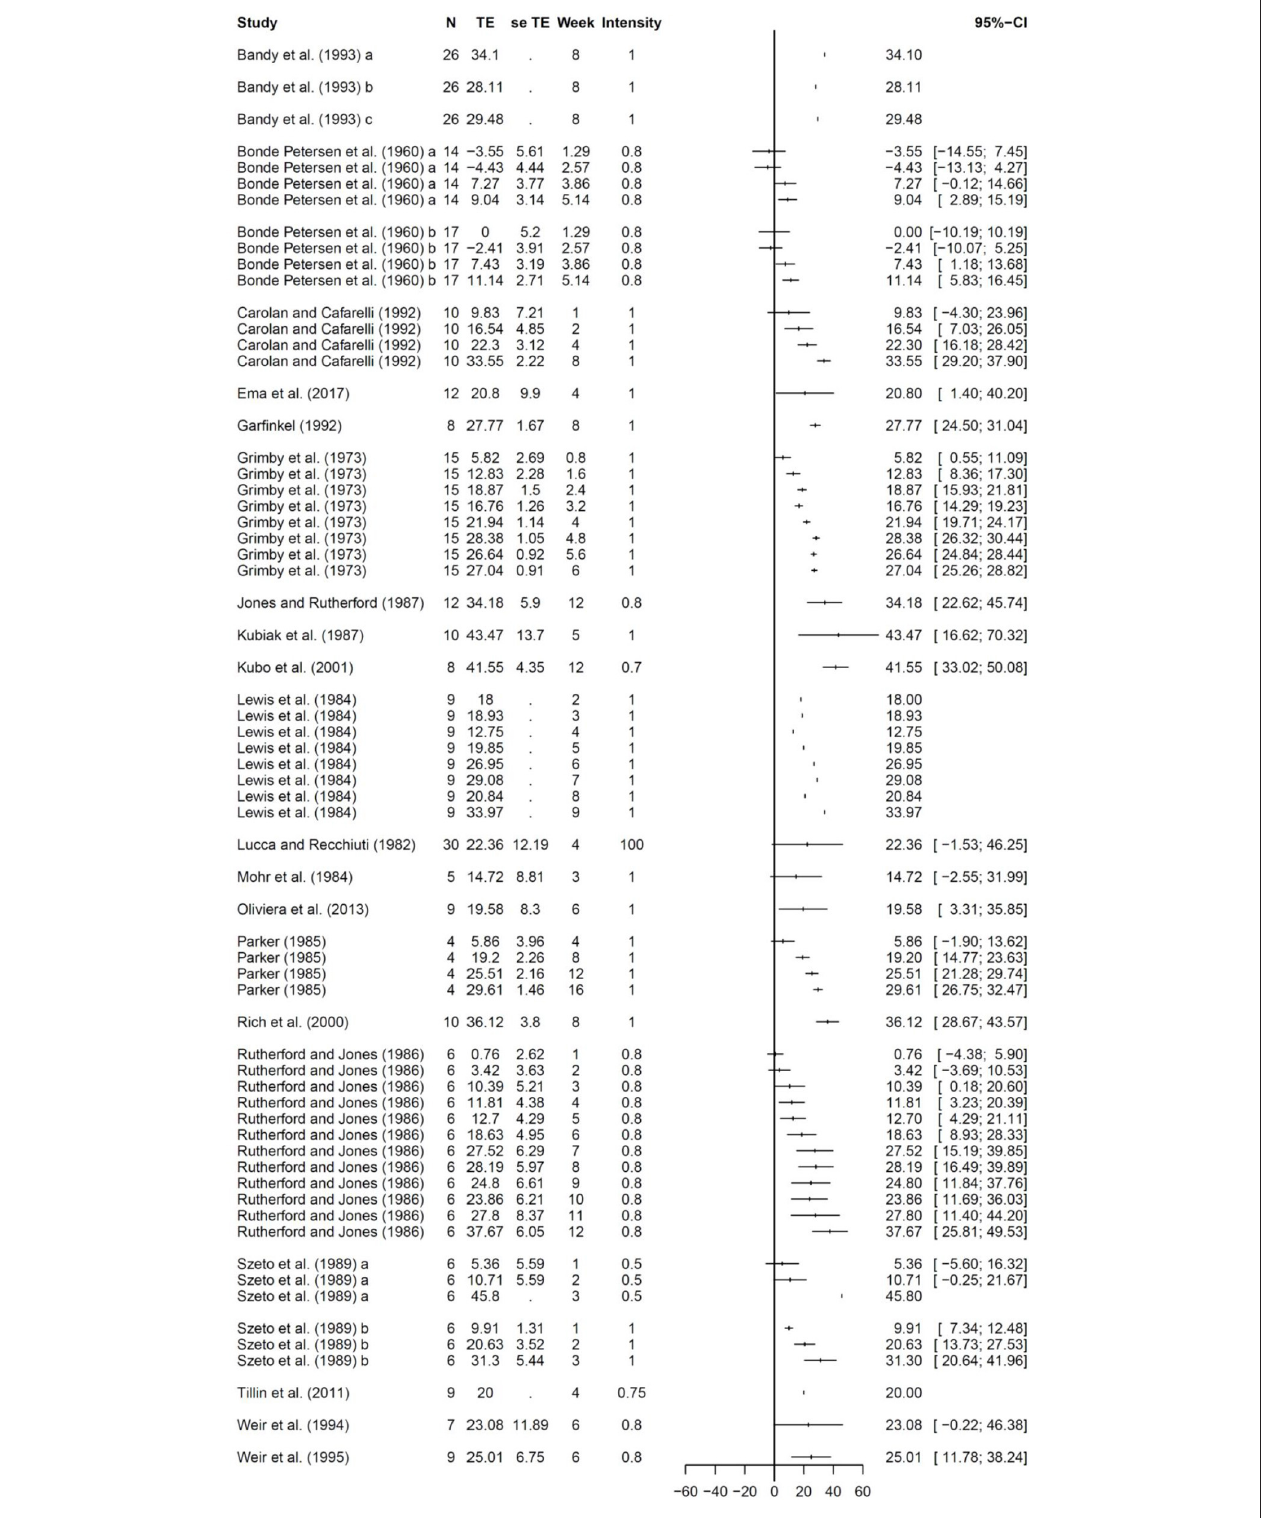
FIGURE 9 | Forest plot of the data on change in isometric strength. Here N denotes the number of subjects, TE and se TE denote the mean and standard deviation of the treatment effect, week denotes the time point and intensity denotes the training intensity. A training intensity of 1 corresponds to 100% MVC.